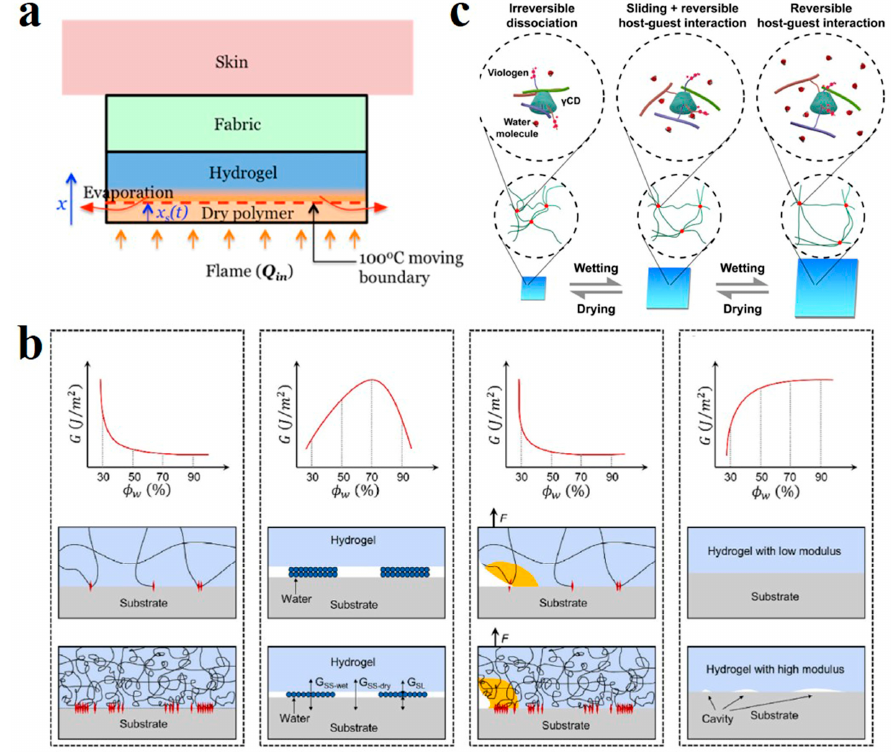
Figure 2. ( a ) Heat dissipation mechanism of polyacrylamide-alginate hybrid hydrogels layers when exposed to open fire. Reprinted with permission from Reference [56]. ( b ) Four factors are involved in the relationship between water content and the adhesion energy of hydrogel. Reprinted with permission from Reference [57]. ( c ) Polymer chain slip or host–guest interaction in hydrogels with different water contents. Reprinted with permission from Reference [58].